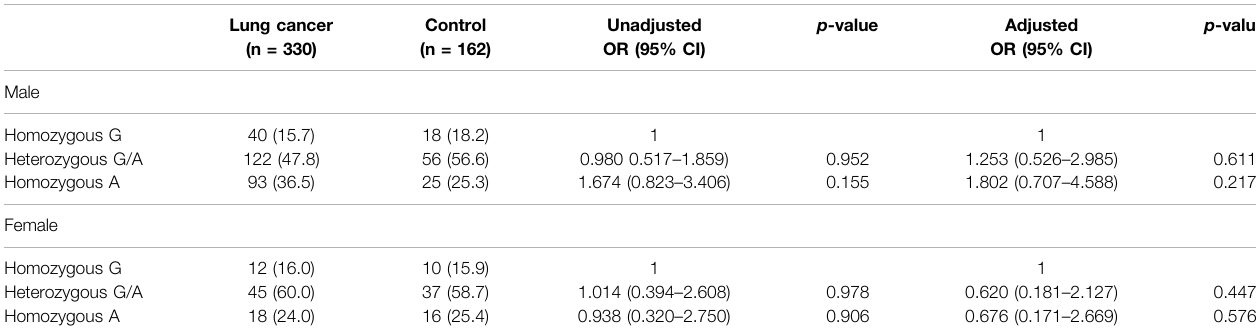
TABLE 5 | The genotype distribution of COX-2 – 1195G/A gene strati fi ed by sex.